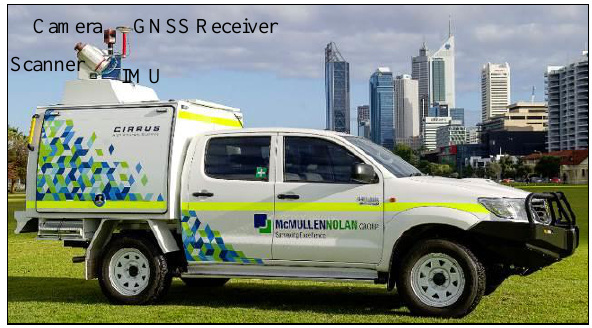
Figure 1. MLTS system and